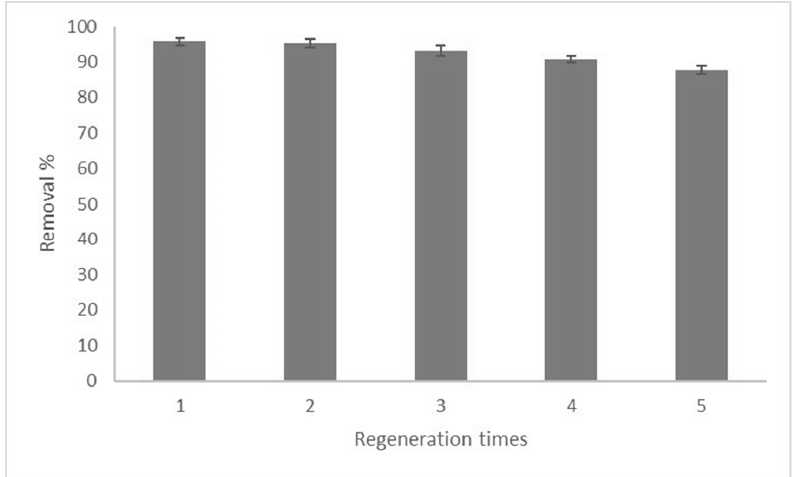
Figure 11. Removal percentage of Pb(II) by GOSCh after five cycles. Figure 10. Removal percentage of Pb(II) by GOSCh after five cycles.